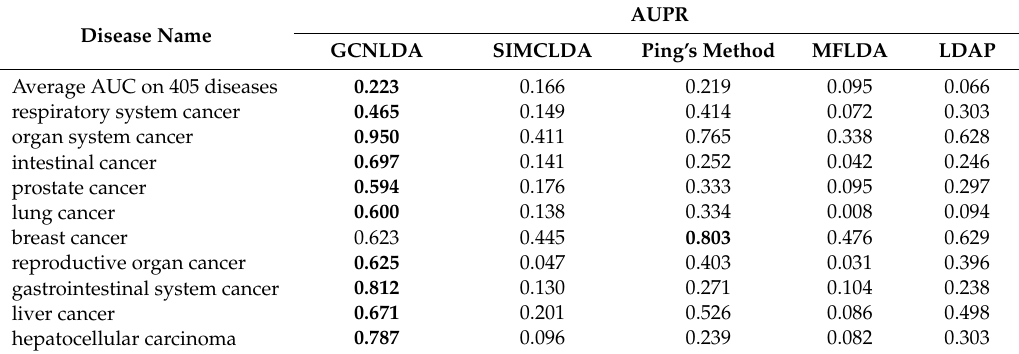
Table 2. AUPRs of GCNLDA and other methods for all the diseases and 10 well-characterized diseases.